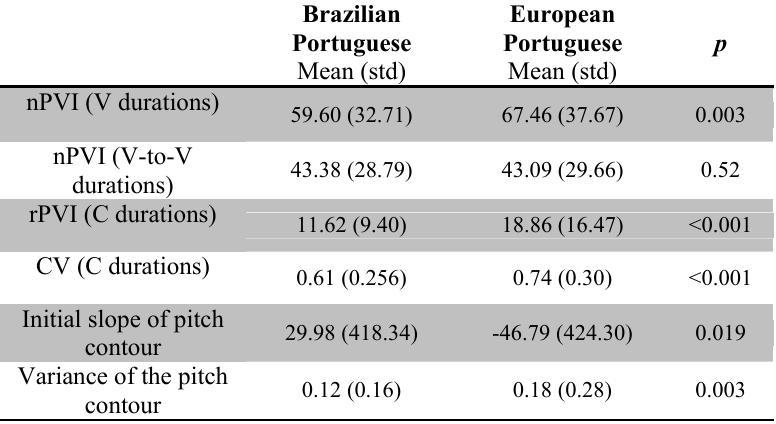
Table IV: Mean, standard deviation and p-value for a group of features, considering Brazilian and European Portuguese speech